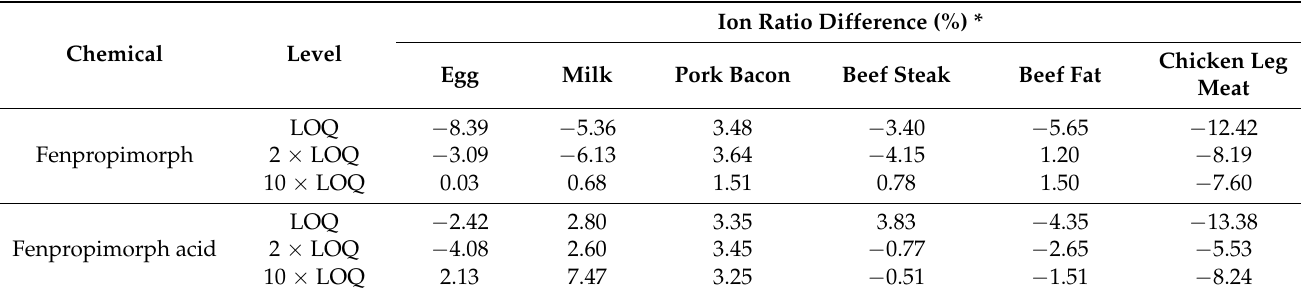
Fenpropimorph acid * The relative difference in ion ratios (%) was calculated from the ion ratio of two MRM transitions in the sample and the ion ratio of two MRM transitions in the reference solvent, as described in the Materials and Methods section. The ion ratio in samples was averaged